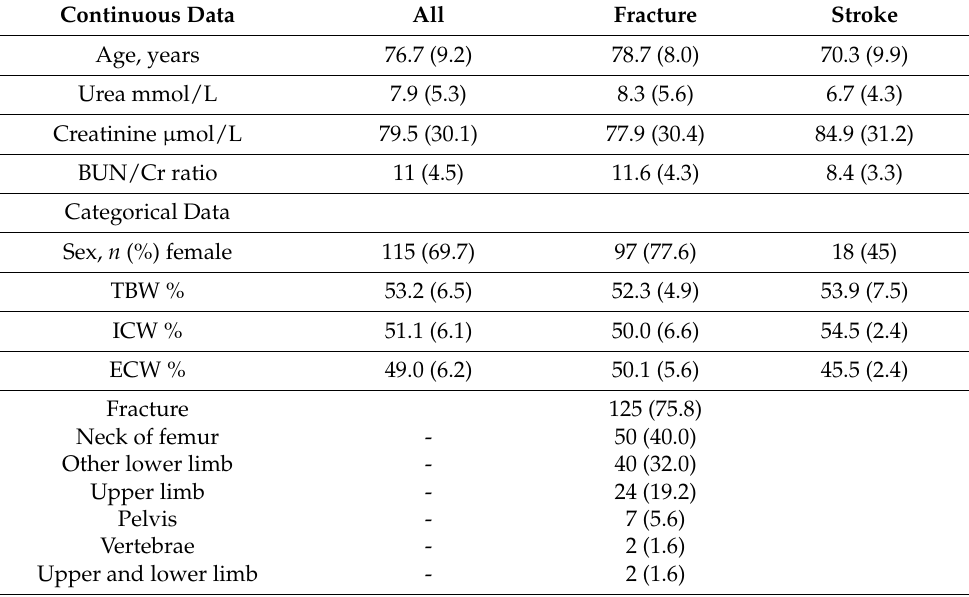
Table 1. Participant